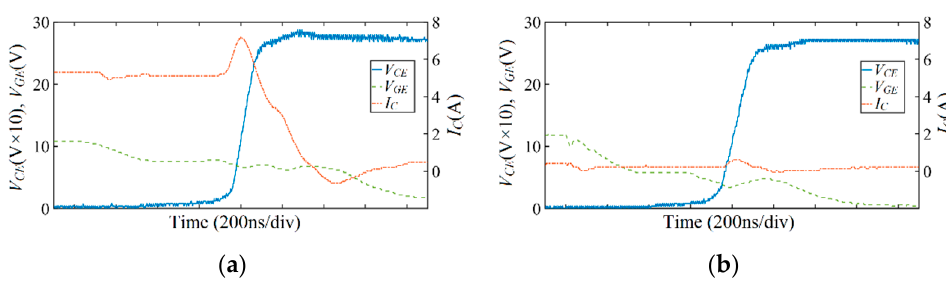
Figure 10. V CE , I C , and V GE waveforms: ( a ) At turn-off transition of the high-side IGBT; ( b ) At turn-off transition of the low-side IGBT.